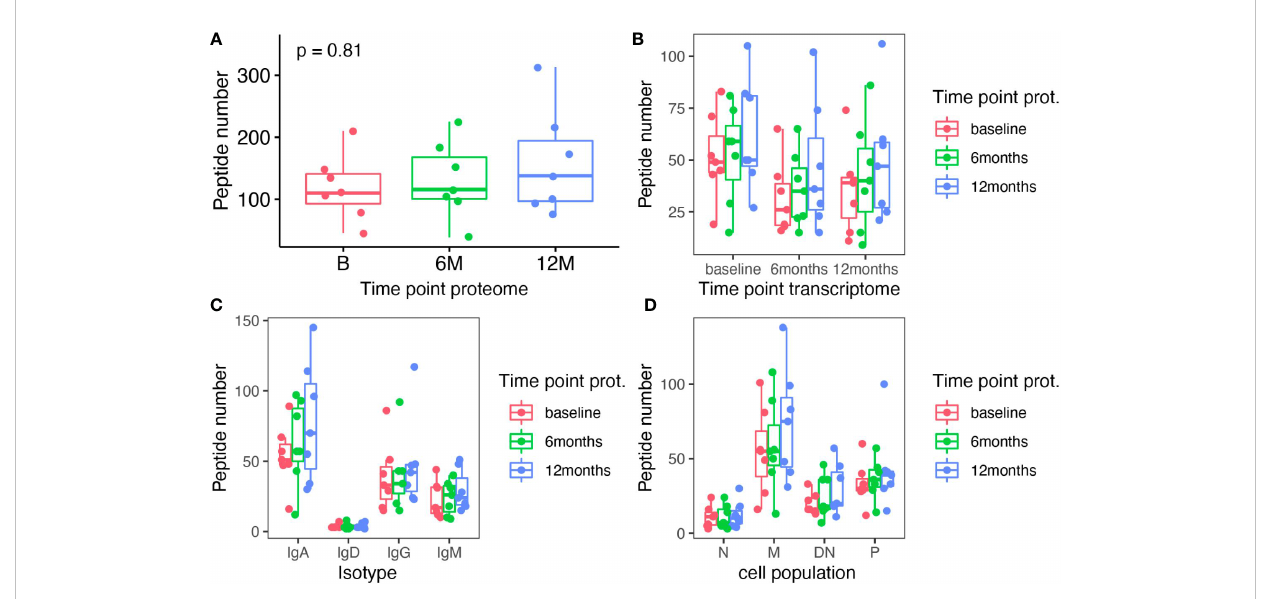
FIGURE 4 Analysis of Ig peptides that speci fi cally aligned to Ig transcriptome sequences in each individual patient. (A) The total number of speci fi c Ig peptides recovered at each time-point (baseline (B), 6 months (6M) and 12 months (12M) following cladribine treatment) is shown. (B) Speci fi c Ig peptides from each time point (color coded) are plotted against the matching Ig transcriptome sequence (x axis) from each time-point. (C) Speci fi c Ig peptides from each time point (color coded) are plotted against the matching Ig transcriptome sequence sorted by isotypes (x axis) from each time- point. (D) Speci fi c Ig peptides from each time point (color coded) are plotted against the matching Ig transcriptome sequence sorted according to B cell subsets (x axis) from each time-point. None of the differences between the different time points reached signi fi cance (Kruskal Wallis